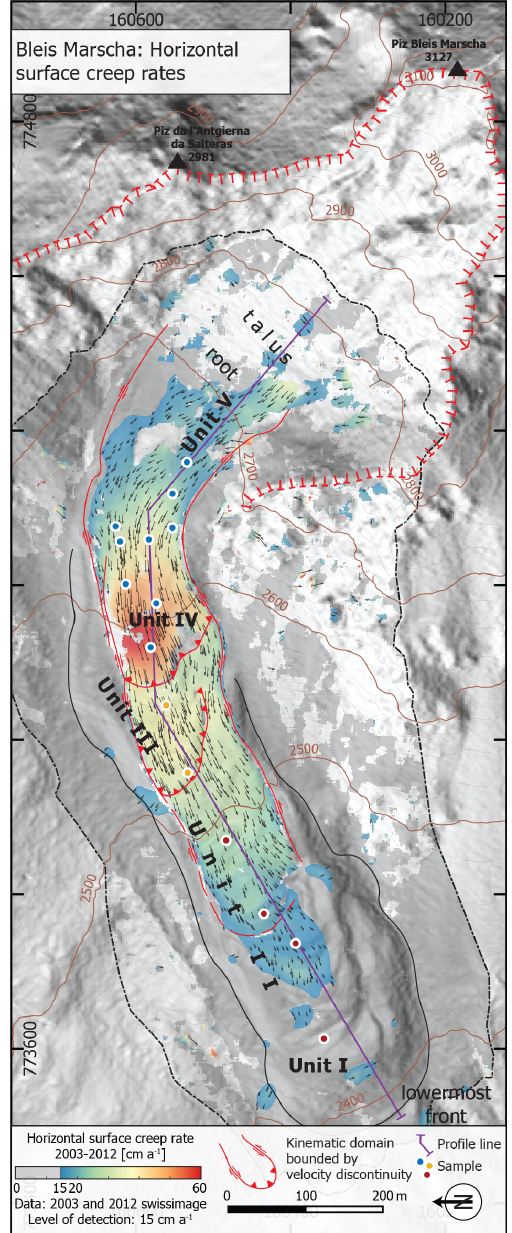
Figure 8. Modern horizontal surface creep rates derived from two orthophotos from 2003 and 2012. Level of detection is 15cma − 1 . The long temporal baseline of 9 years averages interannual vari- abilities in rock glacier creep rates and is a robust estimate of modern, short-term surface kinematics. Important morphological (Fig. 4) and kinematic discontinuities (decorrelation gaps and step- wise changes in surface creep rate) largely coincide along morpho- logical unit boundaries. Areas below the level of detection are con- sidered immobile except for the lowermost front (unit I), where a fresh frontal boulder apron and comparison with the 1988 or- thophoto indicate slow surface movement (5–10cma − 1 ) (hillshade background map reproduced with the authorization of the Swiss Federal Office of Topography,